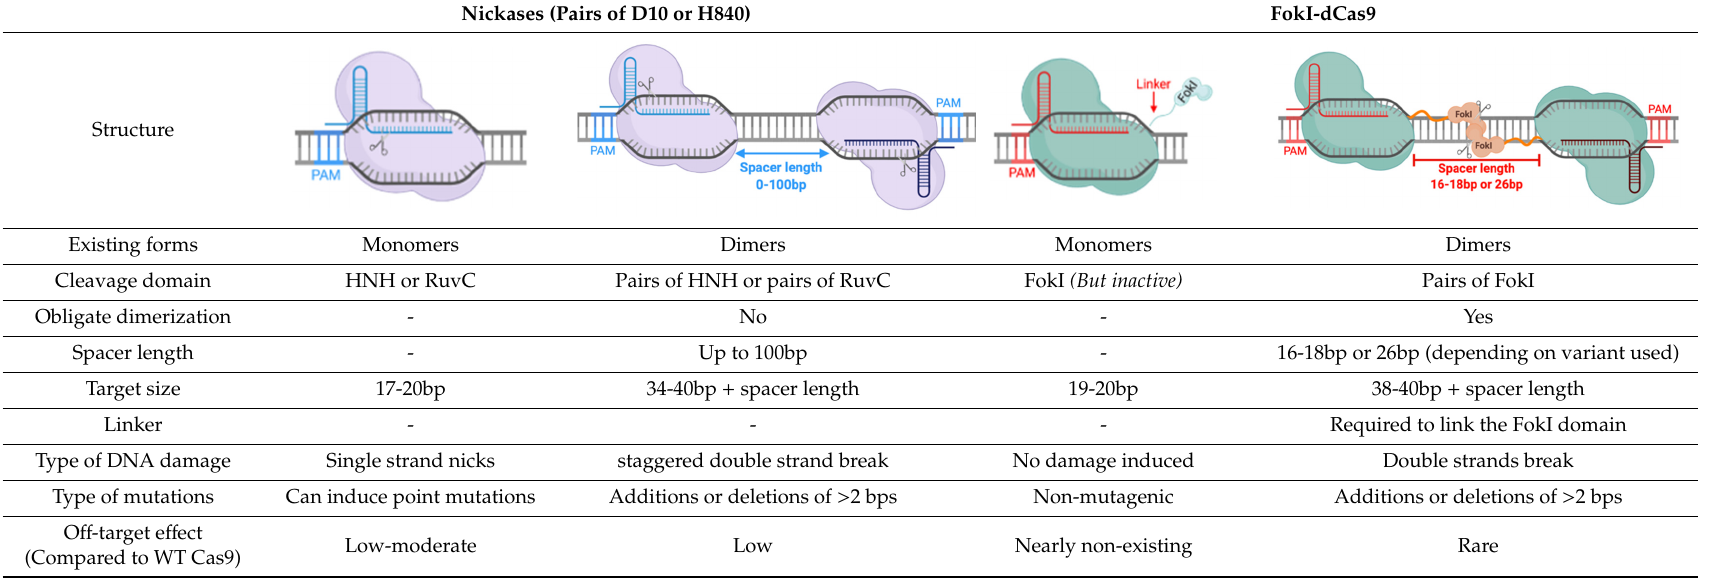
Table 2. Comparison between genomic editing activities of Nickases versus FokI – dCas9 .